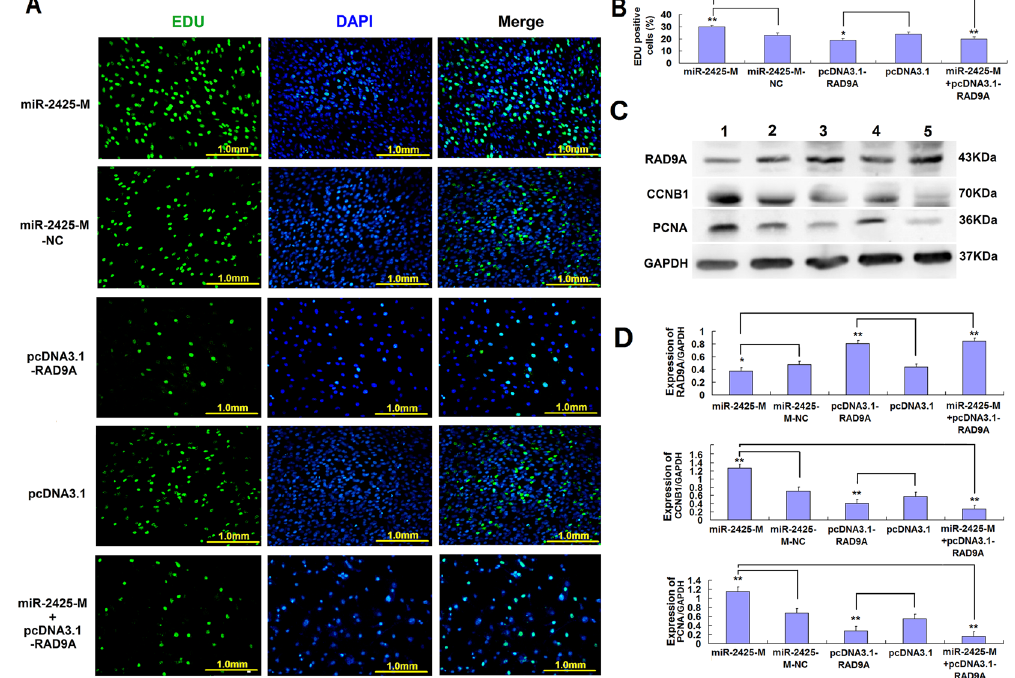
Figure 5. Results of RAD9A rescue experiment. ( A ) MDSCs were labeled with EdU. EdU-positive cells, green; cell nuclei, blue; magnification, 200 × . ( B ) Percentage of EdU-positive cells, n = 6. ( C ) RAD9A, CCNB1, and PCNA protein expression was examined 48 h after transfection with the following constructs: (1) miR-2425-M, (2) miR-2425-M-NC, (3) pcDNA3.1-RAD9A, (4) pcDNA3.1, (5) miR-2425-M + pcDNA3.1-RAD9A. ( D ) Quantified data shown in ( C ). * P < 0.05, ** P < 0.01, NS: no significant